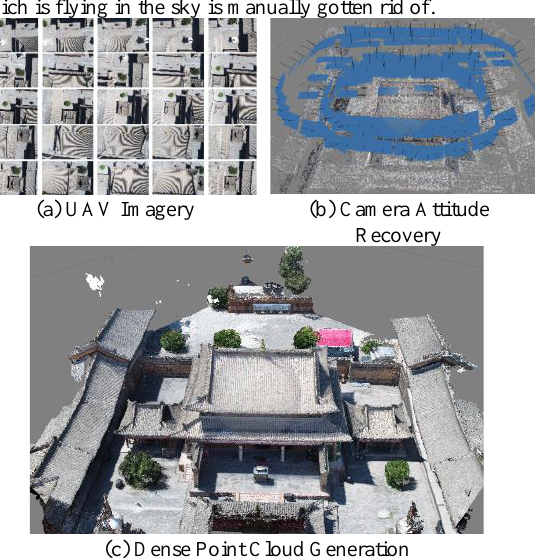
Fig.3 The data acquisition and processing for Baoguang